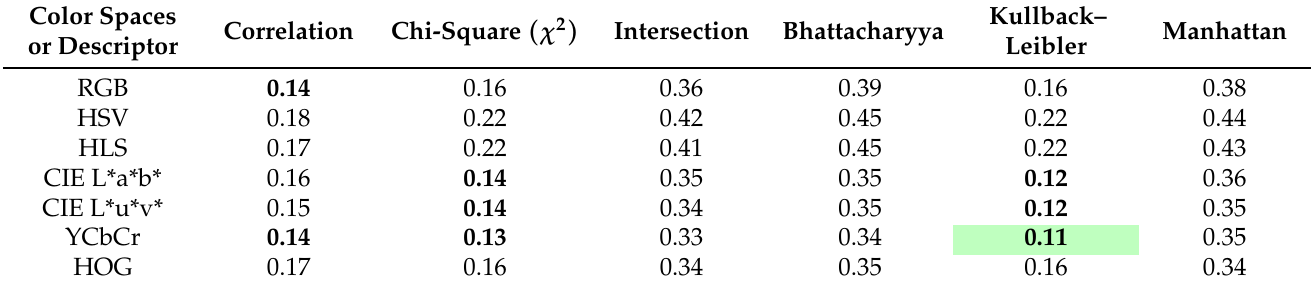
Table 5. S scores calculated for the 1st video with 4